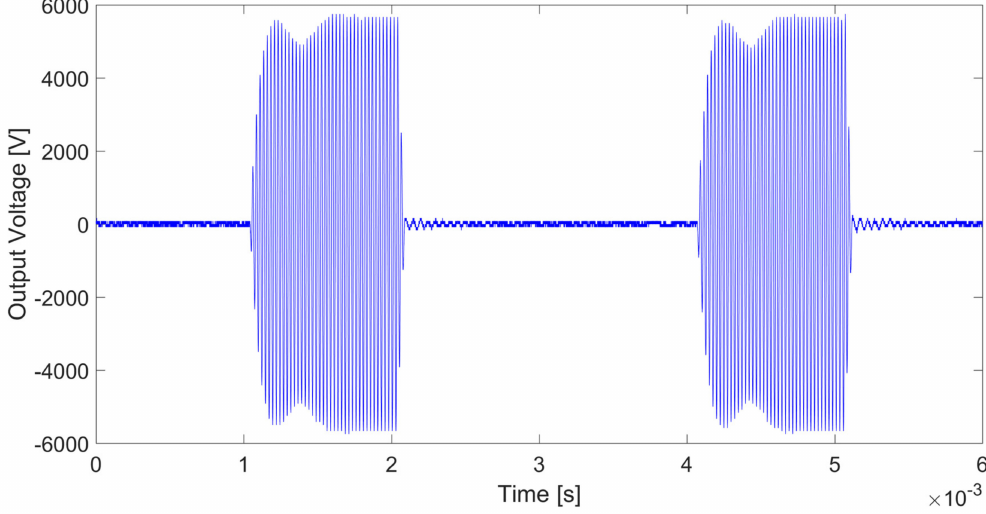
Figure 4. Example of on / o ff output voltage modulation with 1 ms “on” and 2 ms “o ff